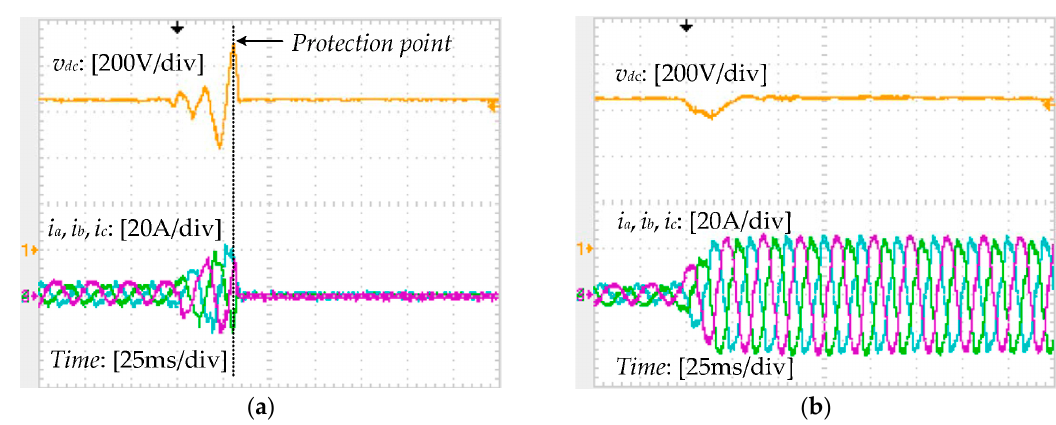
Figure 9. Main operating waveforms of the VSR when load power is changed from 2 kW to 10 kW. ( a ) with conventional PI control; ( b ) with the proposed ADRC.